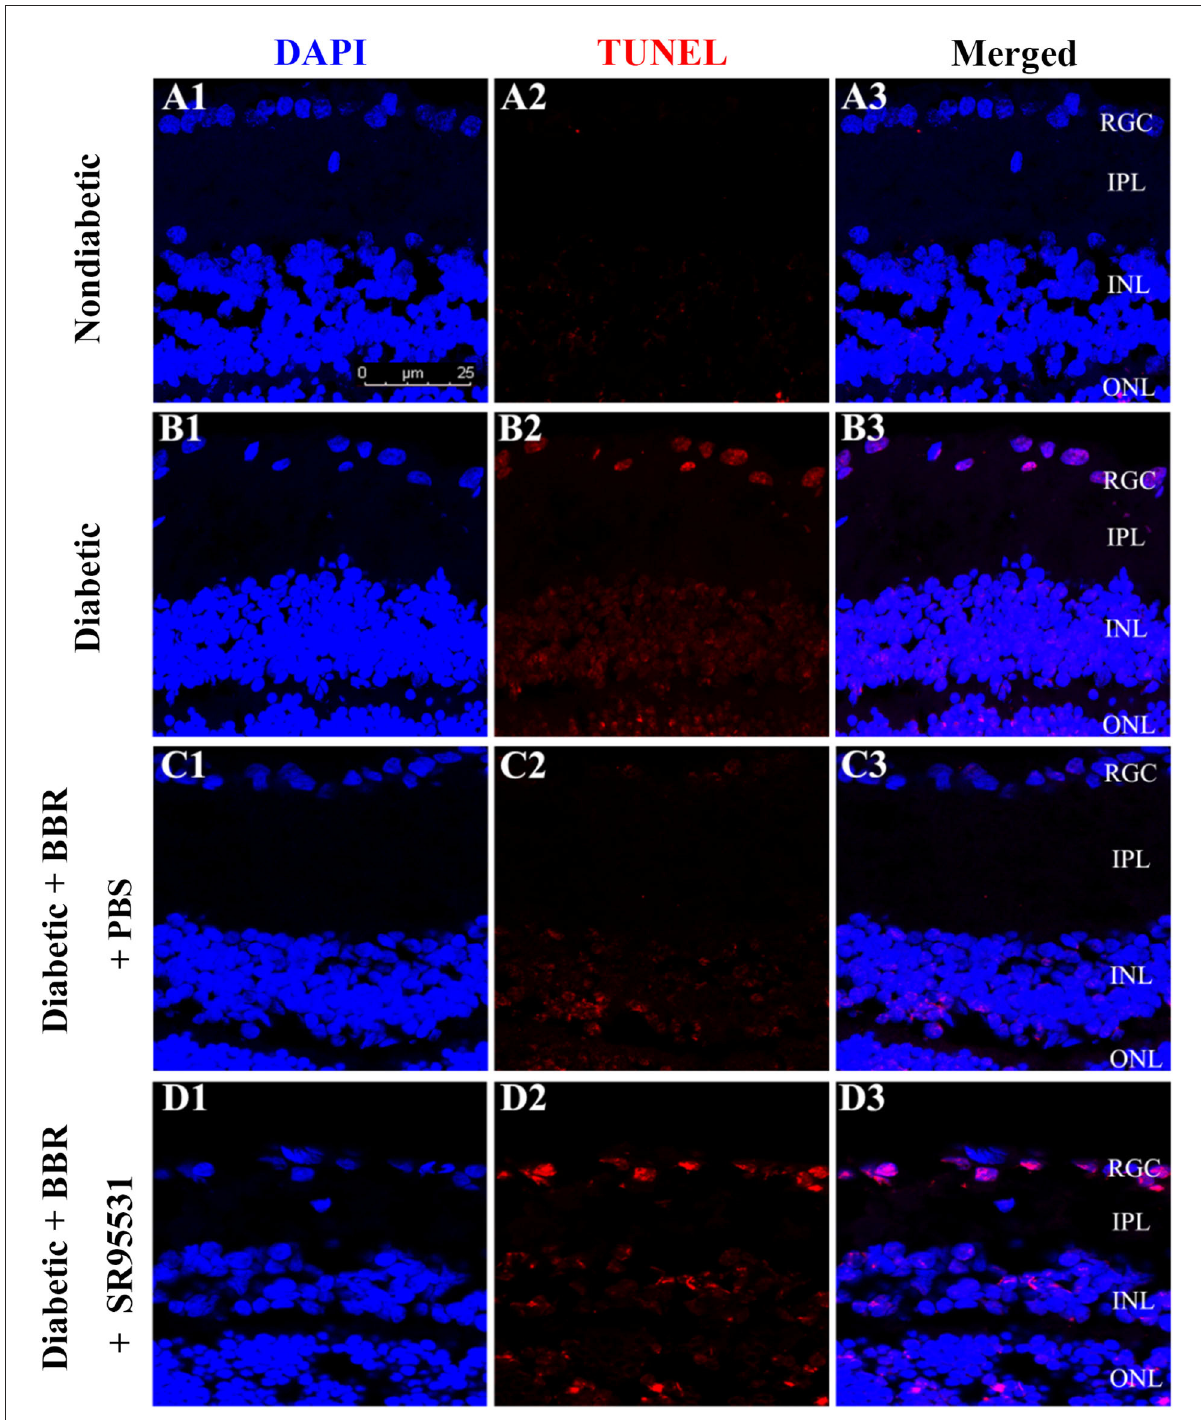
FIGURE4 Representative TUNEL (red), DAPI (blue), and merged confocal microscopy images of frozen 10- µ m-thick retinal sections from rats in the non-diabetic (A1–A3) , diabetic (B1–B3) , diabetic + BBR + PBS (C1–C3) , and the diabetic + BBR + SR95531 (D1–D3) groups. All images were obtained at the same magnification (scale bars, 25 µ m; RGC, retinal ganglion cell layer; IPL, inner plexiform layer; INL, inner nuclear layer; ONL, outer nuclear